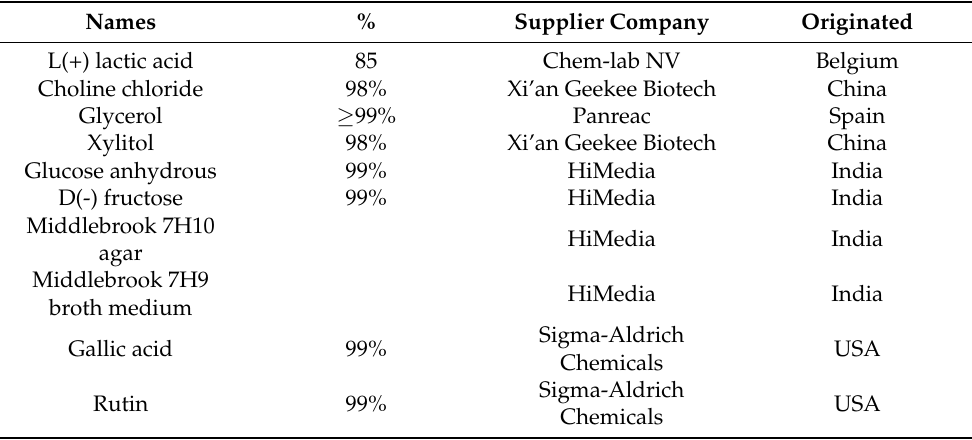
Table 1. Chemical materials and reagents used in this study.